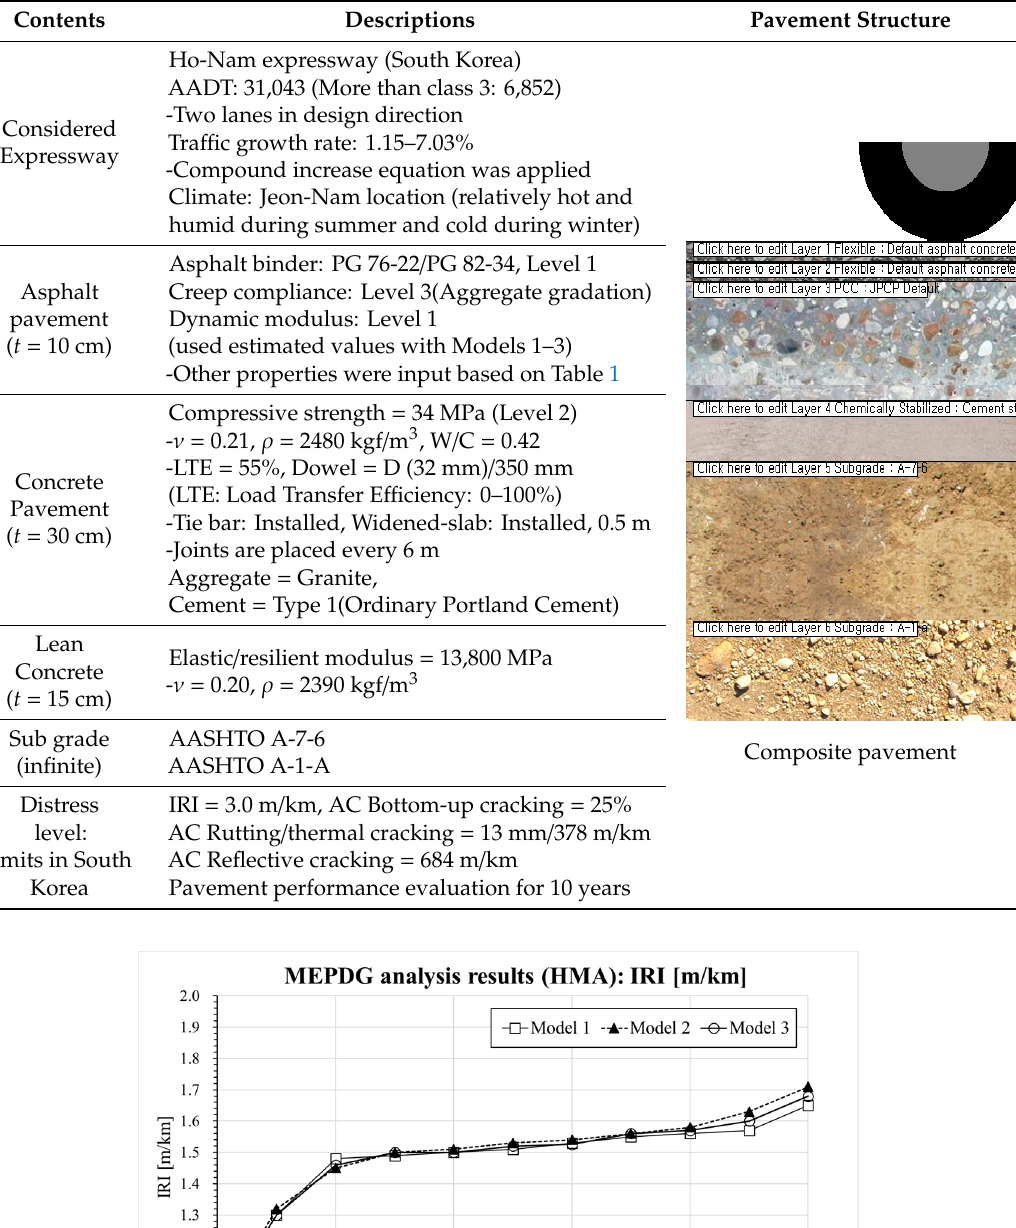
Table 5. Input parameters for the AASHTOWare mechanistic-empirical pavement design guide (MEPDG) analysis.